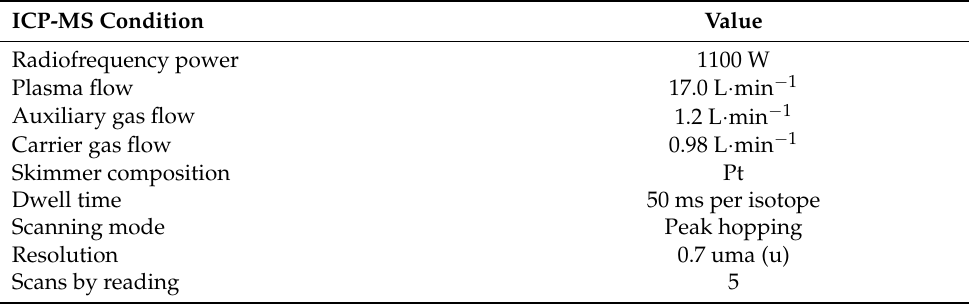
Table 1. ICP-MS conditions applied for elemental